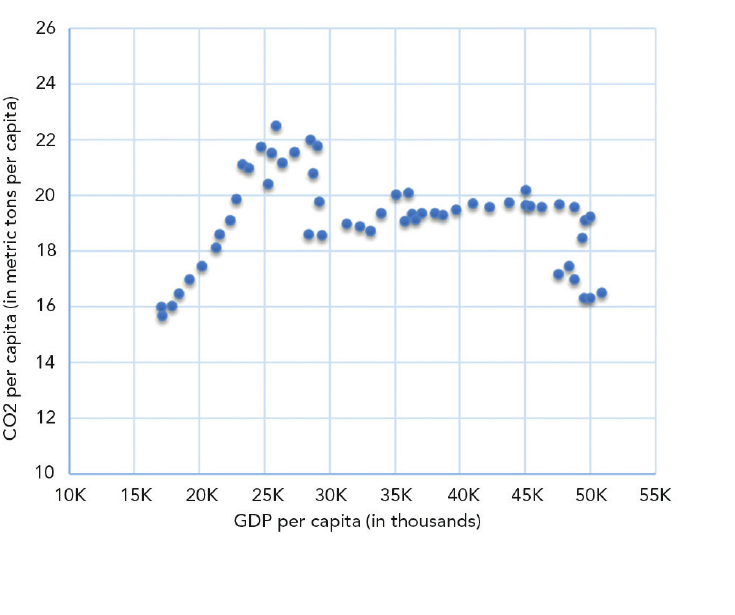
Figure 5 – United States GDP per capita and CO2 per